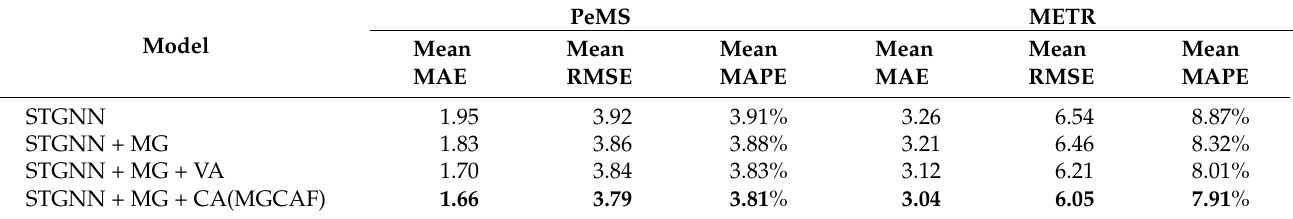
Table 3. Ablation study. STGNN: a general spatiotemporal graph neural network; MG: using the multigraph construction mechanism; VA: using the vanilla attention layer for feature fusion; CA: using the cross-attention layer for feature